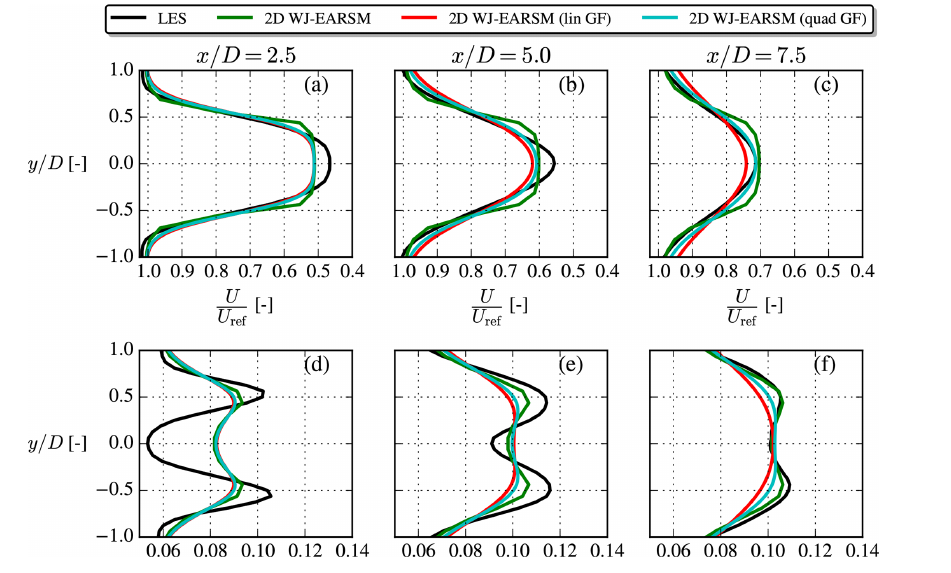
Figure C2. Gaussian-filtered (GF) wake